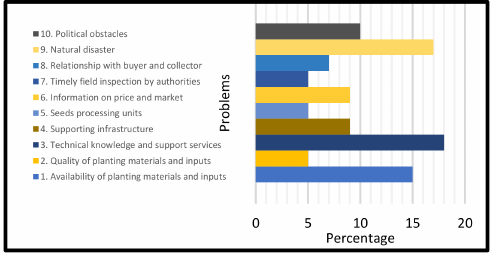
Figure 25. Problems with vegetable seed farming.